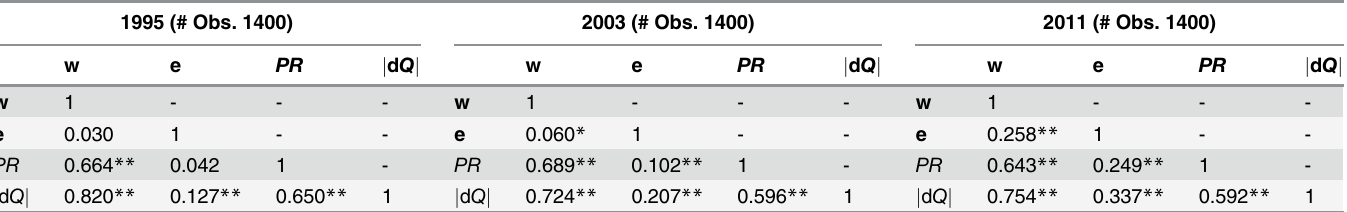
Table 3. Correlation coefficient matrix among the four key-industry-identification methods for selected years. The first is the Laumas method of back- ward linkages, w . The second is the eigenvector method of backward linkages, e . The third is PageRank centrality, PR . The fourth is community coreness measure j d Q j . ** and * mean that the coefficient is significant at 1% level and at 5% level respectively. 1995 (# Obs.